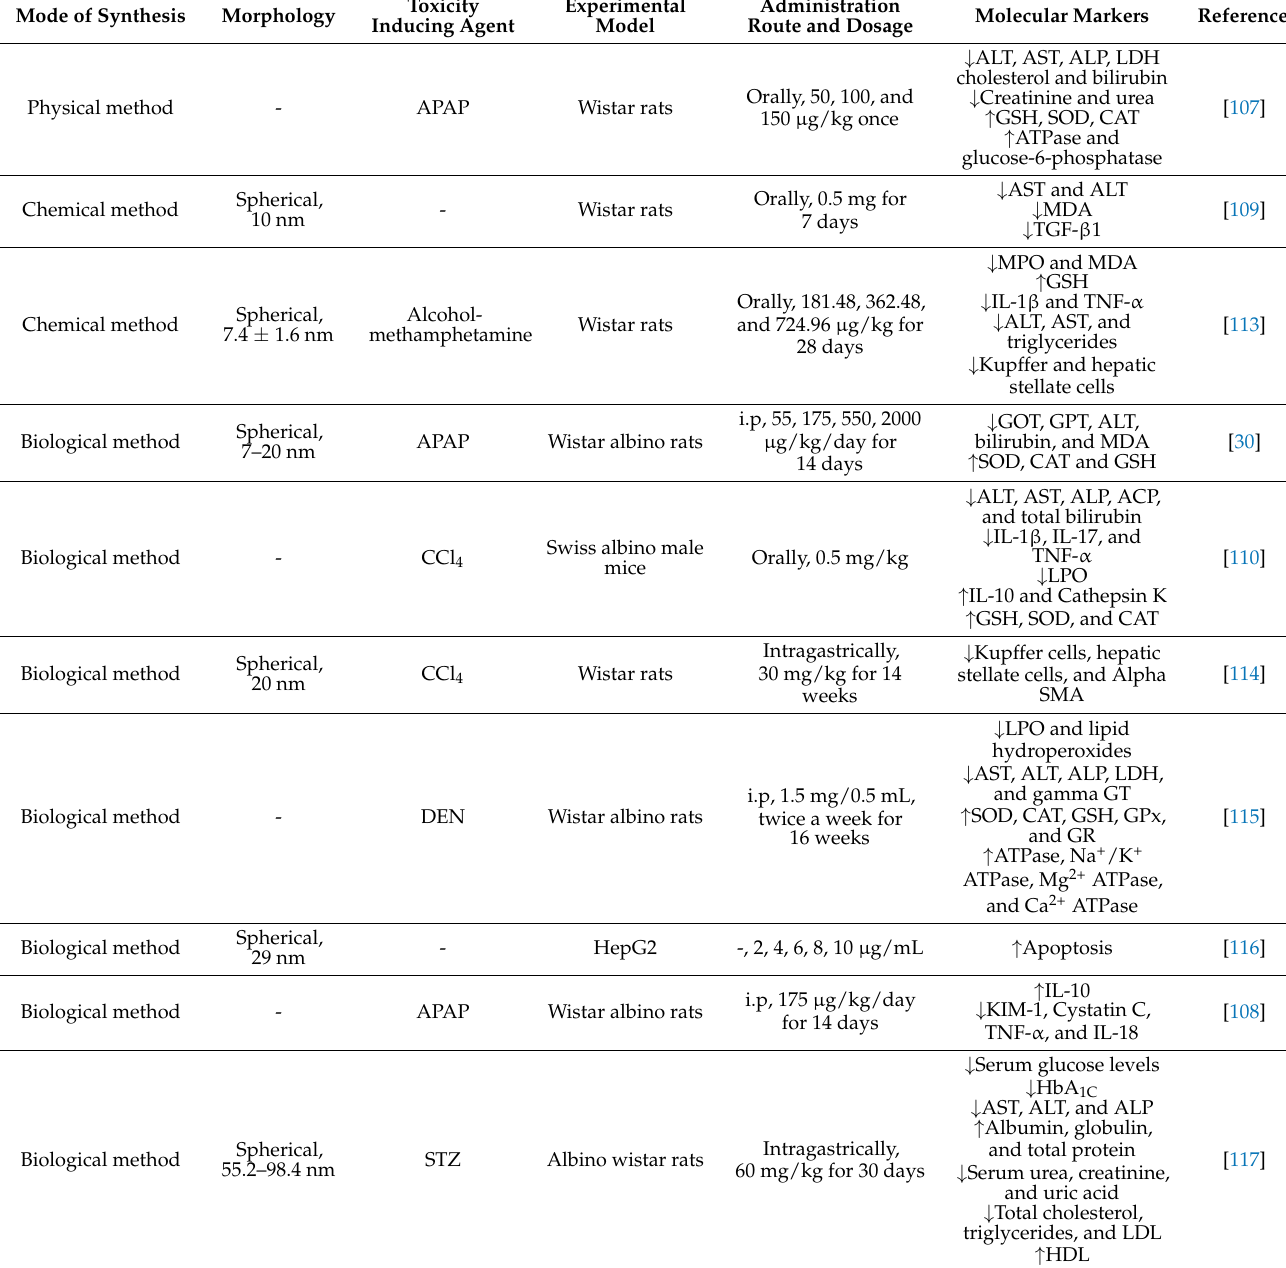
Table 3. Summary of the ameliorative effects of AuNPs against hepato-renal